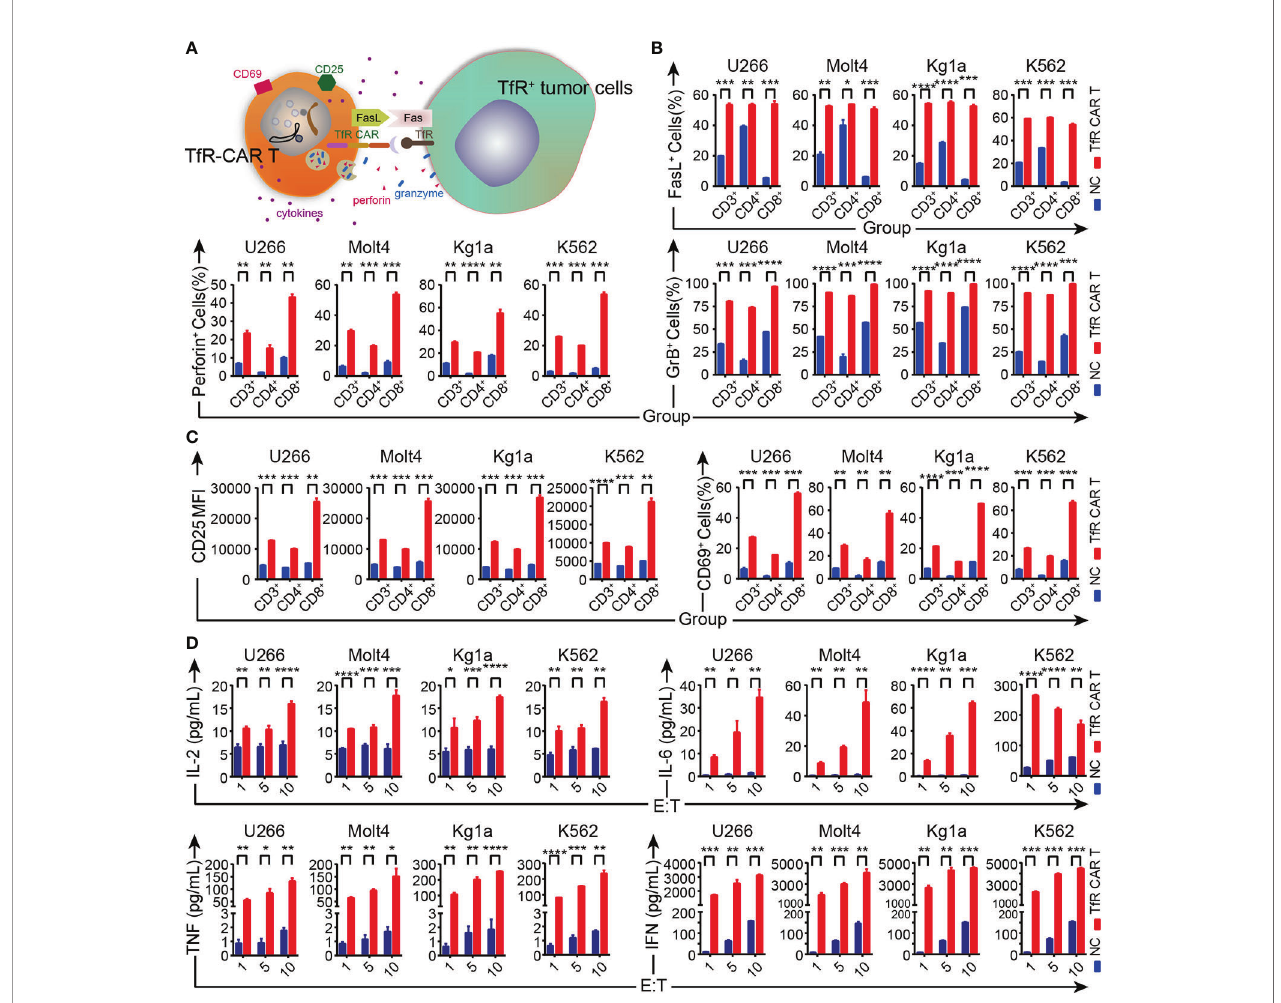
FIGURE 3 | Analysis of TfR-CAR T cells degranulation, activation, and cytokine secretion capacity. (A) Schematic representation for the effector mechanisms of TfR-CAR T cells. CAR T-cells are activated upon recognition of TfR + target cells, which resulted in upregulation of activation/cytotoxic markers on T cells, and production of pro- in fl ammatory cytokines. (B, C) TfR-CAR T cells and NC T cells were co-cultured with TfR + hematological malignant cells (E/T ratio = 10:1) for 20 h. The expression of the cytotoxic markers FasL, perforin, and granzyme B were determined by FCM in gated CD3 + , CD4 + and CD8 + T cell populations (B) , as well as the activation markers CD25 and CD69 (C) . (D) Cytokines released by T cells at indicated E/T ratios were detected by cytometric bead assay. Results are representative of three independent experiments performed with CAR T cells derived from three different donors. All data are presented as means ± SD. * P < 0.05, ** P < 0.01, *** P < 0.001, **** P <